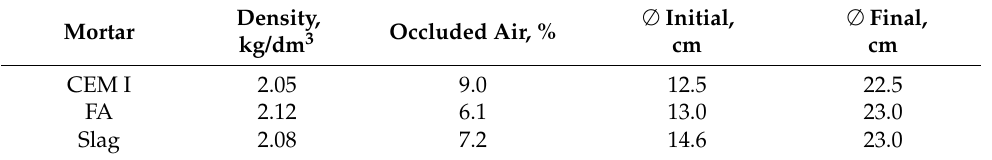
Table 2. Early age characterization (fresh properties measured on each mortar mix). Mortar